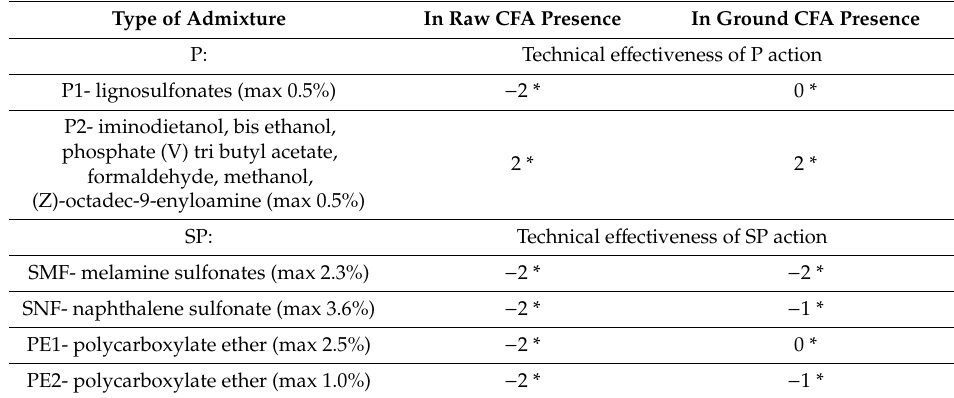
Table 11. Influence of raw and ground CFA addition on the technical e ff ectiveness level of P and SP action. Type of Admixture In Raw CFA Presence In Ground CFA Presence P: Technical e ff ectiveness of P